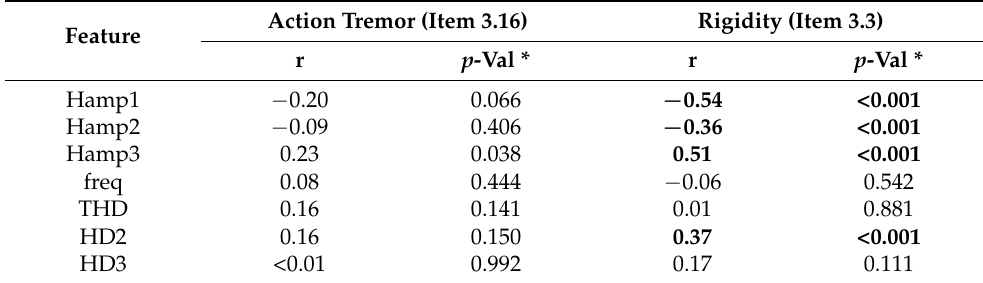
Table 5. Spearman’s rank correlation coefficients in de novo parkinsonian patients.